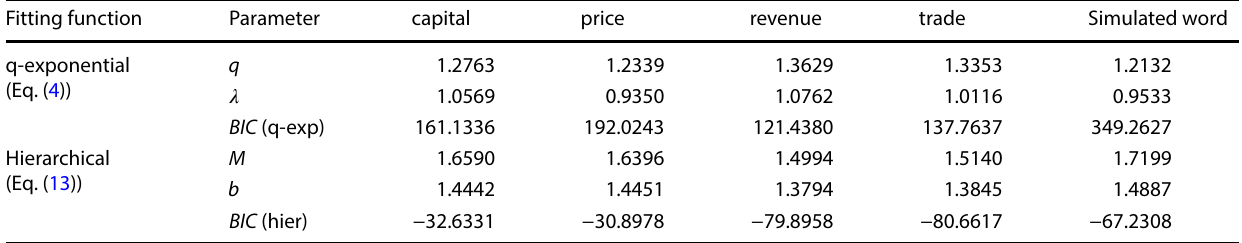
Hierarchical (Eq.